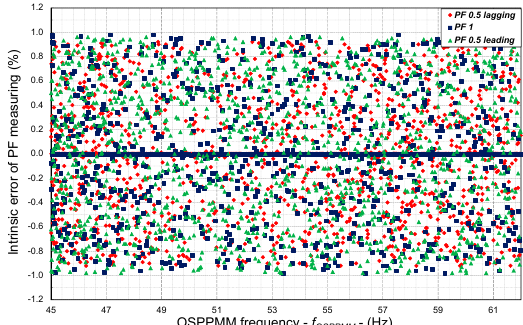
Figure 19. PF meter test: Intrinsic error of PF measuring ( PF : 0.5 lagging, 1, 0.5 leading).